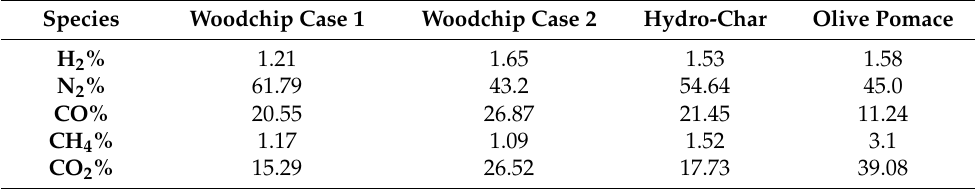
Table 6. Collected syngas mass fractions on dry basis for the four biomasses